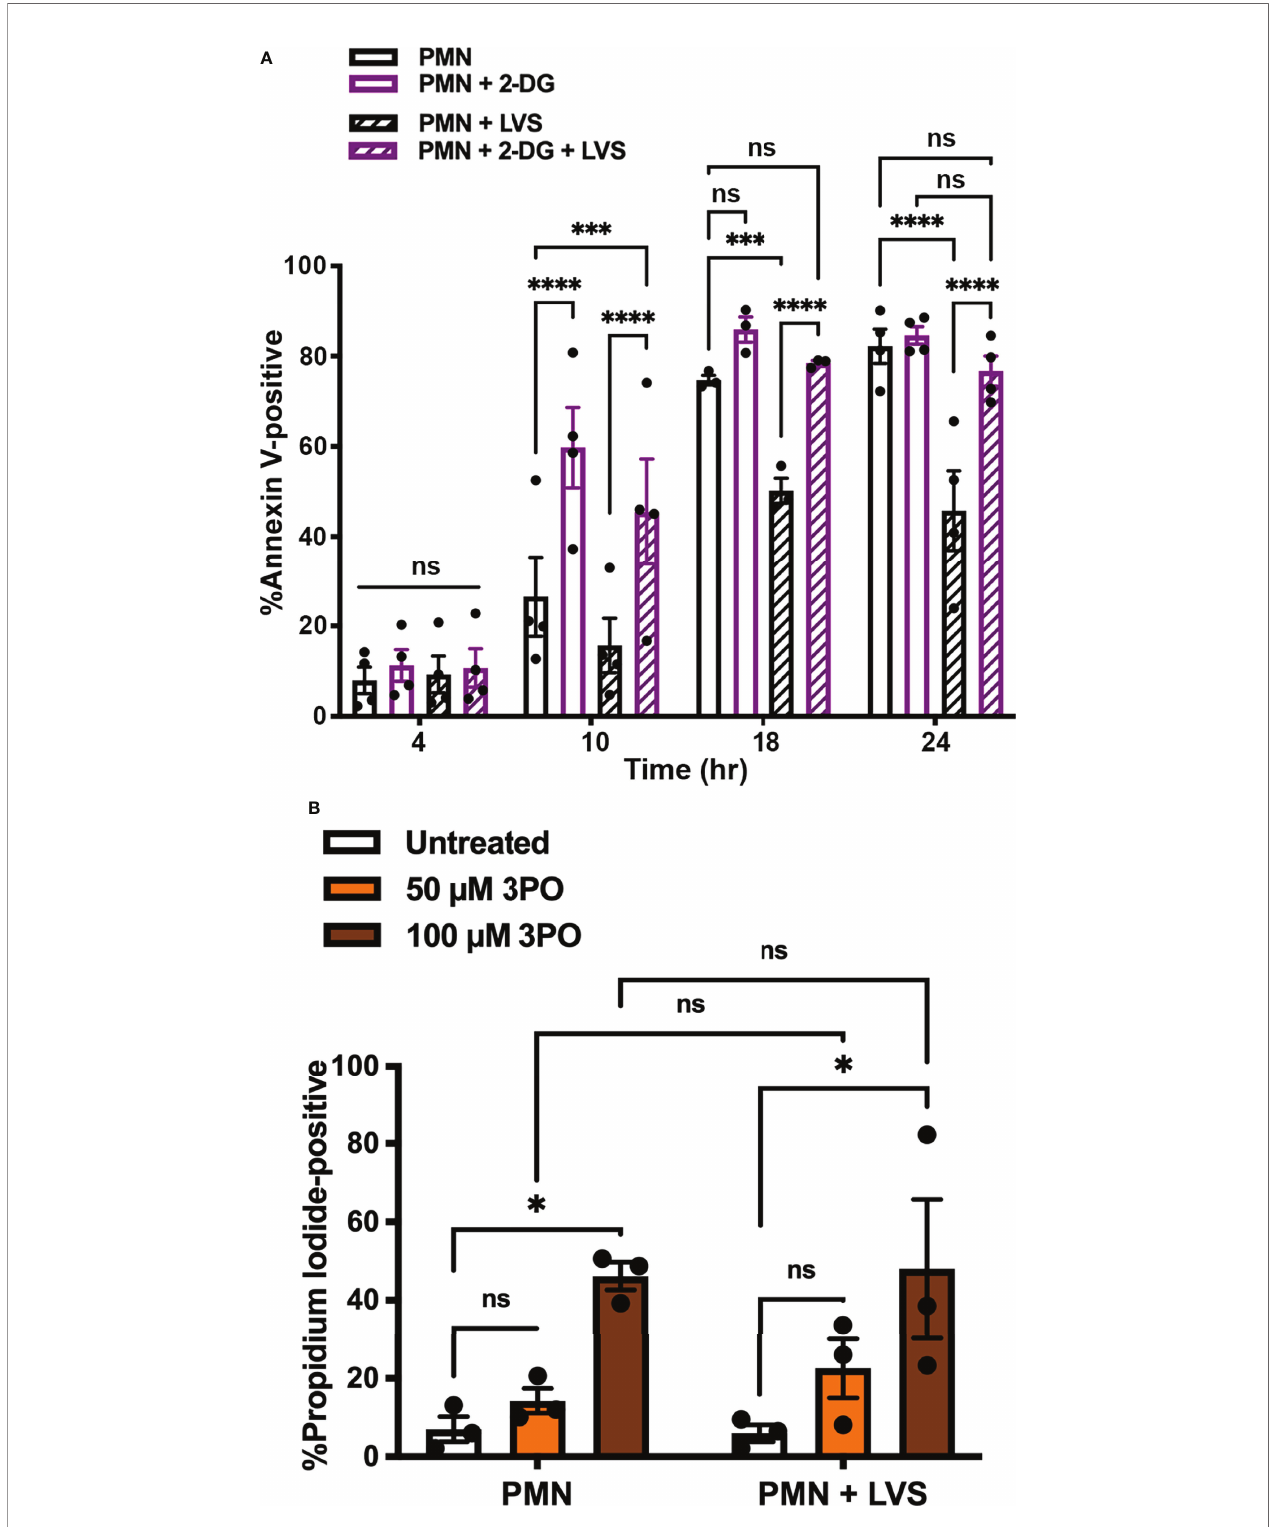
FIGURE 5 | Glycolysis inhibition blocks the ability of LVS to delay PMN apoptosis. (A) Effects of 2-DG on the kinetics of apoptosis of control and LVS-infected cells were measured using Annexin V-FITC staining and fl ow cytometry at the indicated time points, n=4. *** p < 0.001, **** p < 0.0001, ns, not signi fi cant, as indicated. (B) Effects of 3PO on PMN viability at 24 hr as measured by PI staining and fl ow cytometry, n=3. * p <0.05, ns, not signi fi cant, as